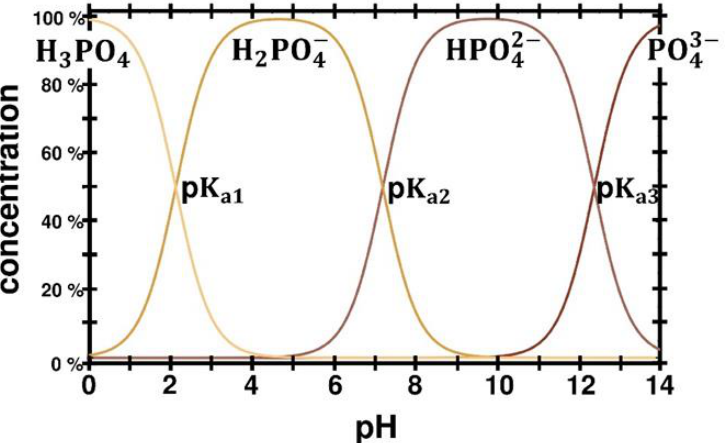
Figure 4. Concentration of phosphate species as a function of the pH value. Reprinted and adapted with permission from Ref. [99]. Copyright 2020 Clarolux.